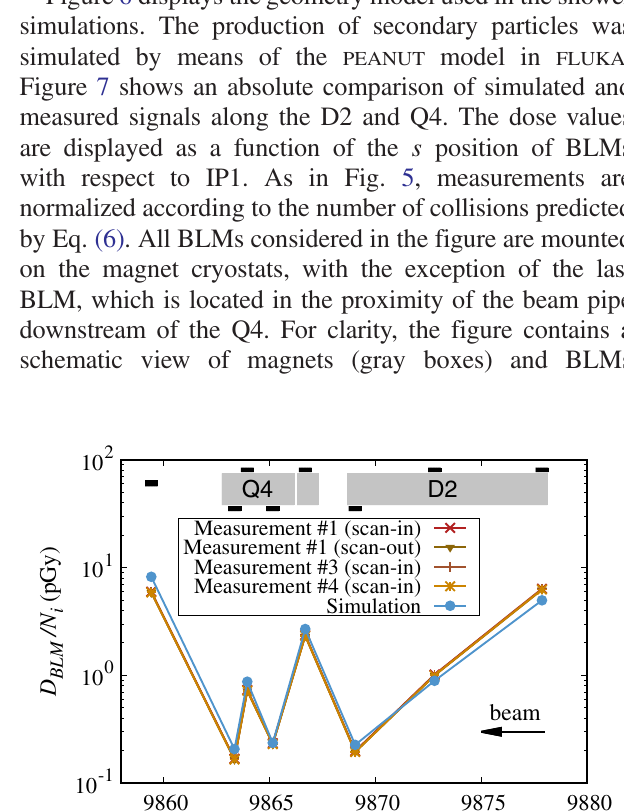
FIG. 7. Simulated and measured BLM signals for proton losses induced by the LHC wire scanner. The measurements derive from a controlled beam loss experiment carried out at 3.5 TeV (see also Fig. 5). The beam direction is from the right to the left. The wire scanner is located at s ¼ 9912 m, approximately 34 m upstream of the first BLM on the D2 cryostat. All dose values are given per inelastic proton-nucleus collision in the wire. The statistical error of simulation results is less than 6%. The data points are connected by lines to guide the